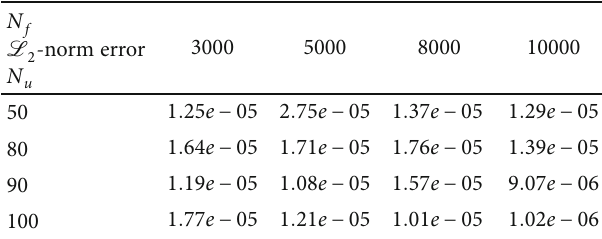
Table 4: mkdv equation: L 2 -norm error between the predicted and exact solutions of u ð t , x Þ for DNN architecture which is constructed by 9 hidden layers with 15 neurons per hidden layer with di ff erent training points N u and collocation points N f .